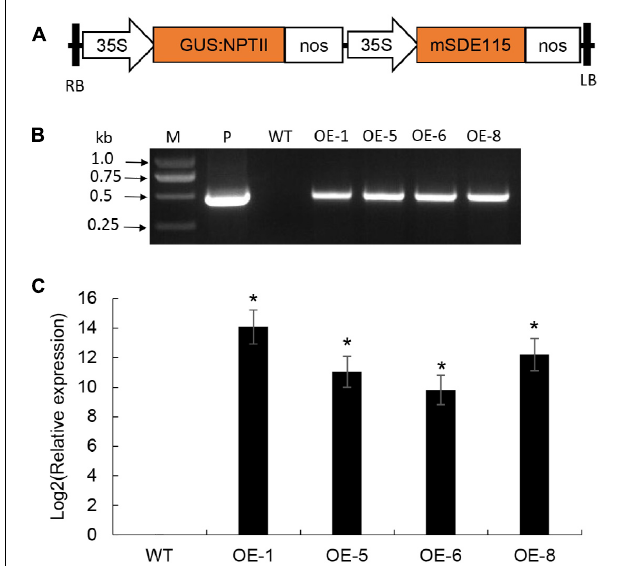
FIGURE 5 | Wanjincheng orange transgenic plants overexpressing mSDE115 . (A) T-DNA structure of plant expression vector for the genetic transformation of citrus. A 35S, CaMV 35S promoter; GUS:NPTII, fusion of β -glucuronidase and neomycin phosphotransferase genes (for the screening of citrus transformants); mSDE115 , the coding sequence of Ca LasSDE115 mature protein; NOS, the nopaline synthase terminator; LB, left border; RB, right border. (B) Identification of transgenic plants by PCR. M, DNA marker, P, p35S:mSDE115 plasmid; WT, wildtype control; OE-#, transgenic plants. (C) Relative expression levels of mSDE115 in transgenic plants. Relative expression of mSDE115 in transgenic plans was normalized against its expression in wildtype control using the citrus GAPDH gene (Mafra et al., 2012) as internal reference. Values are expressed as means ± standard deviation of three independent tests. *on top of the bars indicates significant differences compared to WT control ( p < 0.05, Student’s t